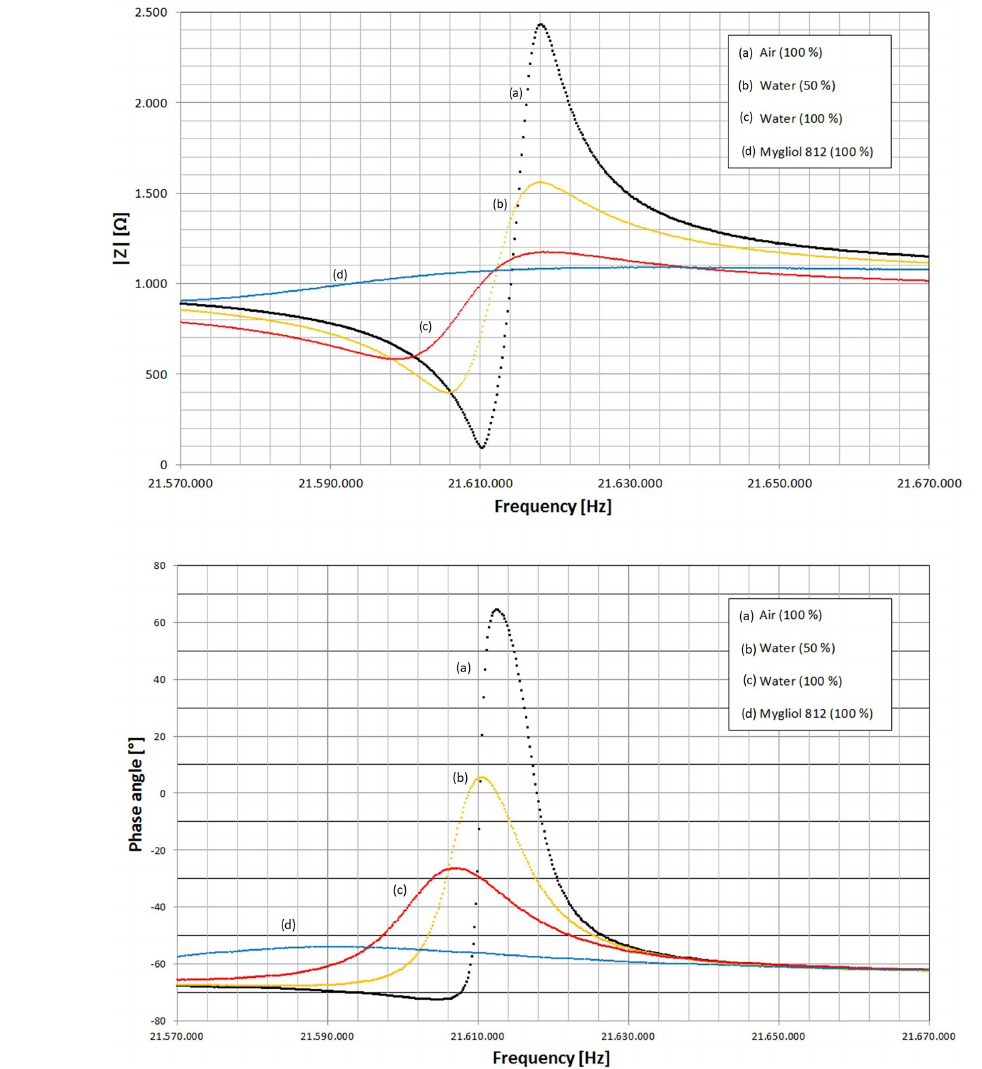
Figure 3. Changes in amplitude (top panel) and phase angle (bottom panel) for different media as obtained from microfluidic chips with integrated QCM using a network analyser. The percentage information indicates the filling level of the microfluidic chip. Where 100% indicates a completely filled chip, while 50% describes a half-filled